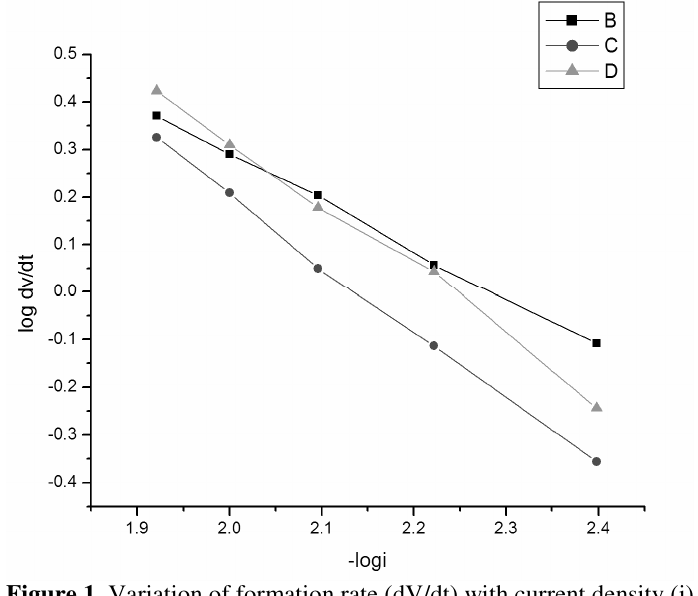
Figure 1. Variation of formation rate (dV/dt) with current density (i) B = Sulphamic acid C = Potassium malonate D = Ammonium